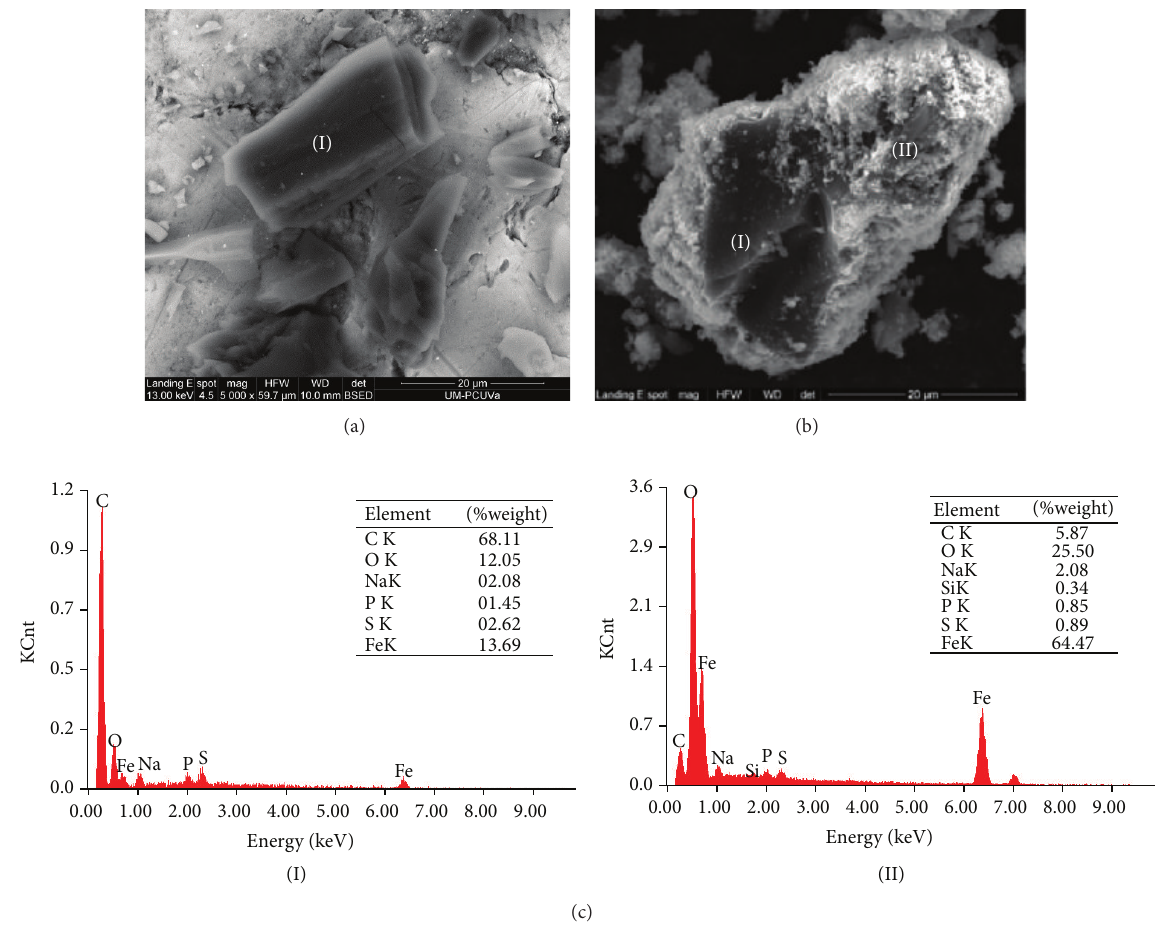
Figure 2: (a) Micrograph for activated carbon; (b) micrograph for magnetic modified carbon support; (c) energy dispersive spectra obtained from the analysis of zones I and II of magnetic modified carbon support.